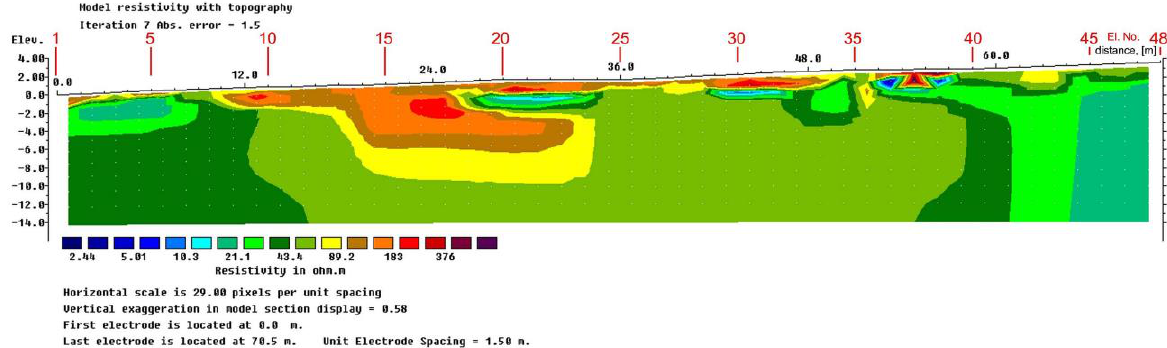
Figure 12. The distribution of the apparent resistivity based on the measurement with the Wenner α array.